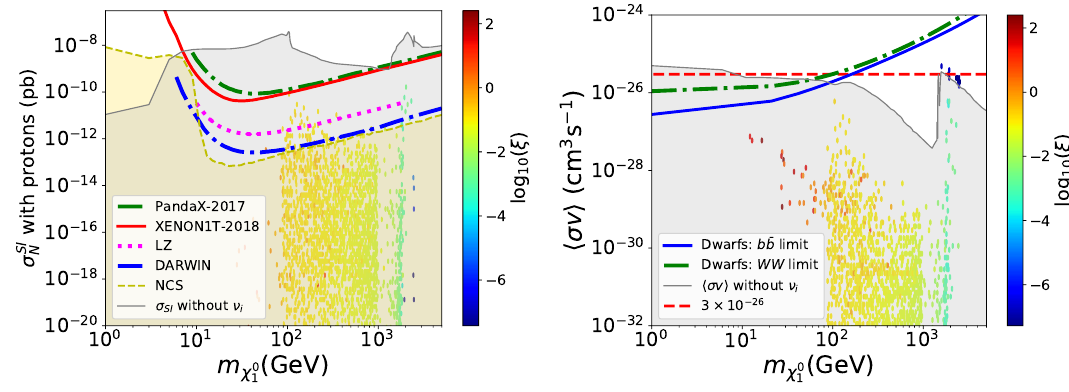
Figure 4 . Left: SI cross-section. We show the currents limits of XENON1T [15], PandaX [45], and the prospects from LZ [16] and DARWIN [17]. We also show the Neutrino Coherent Scatter- ing (NCS) [46, 47] (yellow region). Right: velocity-averaged annihilation cross-section and current indirect detection limits in b (cid:22) b and WW channels [48]. In both plots, we also show the region com- patible with the relic density but without the correct Yukawa couplings that reproduce the neutrino oscillation parameters (grey region). In colors, we also show the (cid:24) variable de(cid:12)ned in eq. (3.1). We computed the SI cross-section ( (cid:27) ) for each point of the scan that was SI